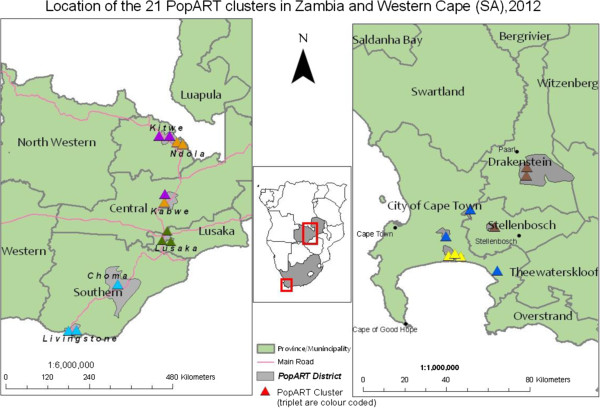
Map showing location of study communities.